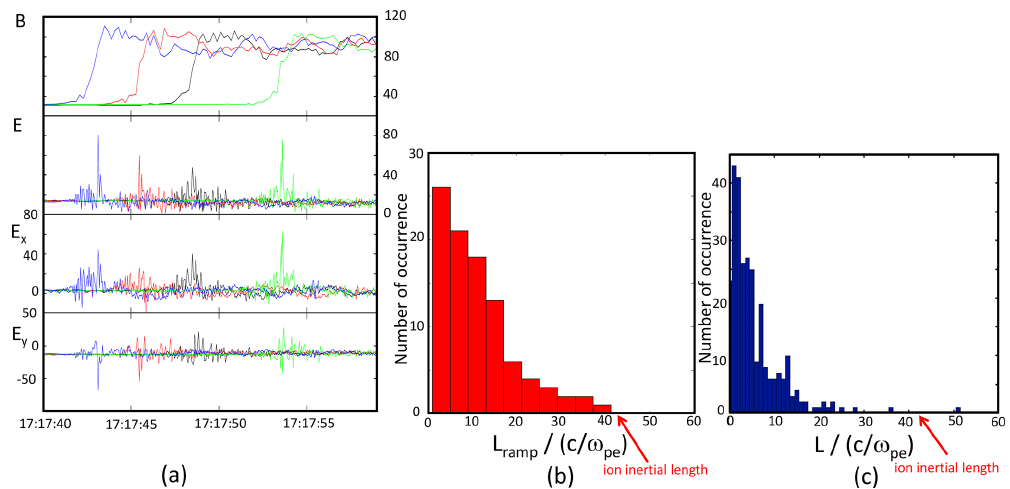
Figure 13. Panels (a) and (c) are reproduced from Walker et al. (2004). Panel (a) displays an example of short-scale electric field structures observed around the crossing of the bow shock by the Cluster quartet on 31 March 2001 at 17:18UT (first panel: spin time-resolution magnetic field magnitude; the following panels display the amplitude of the electric field and E x and E y GSE components, respectively). Panel (b) reproduces the distribution of magnetic field ramp obtained from the present study already shown in Fig. 9a to compare with the distribution of the electric field structures of Walker et al. (2004) shown in (c)